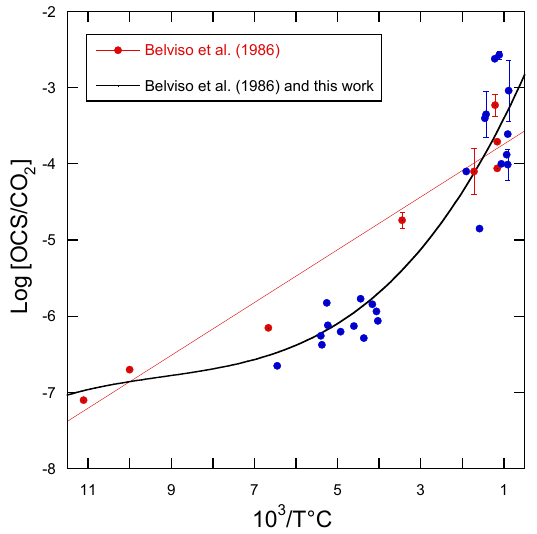
Figure 10. Decimal logarithm of the OCS/CO 2 ratios plotted against the reciprocal of the emission temperature of the gases for volcanoes. The red dots refer to the analytical data published by Belviso et al. (1986) and the red line corresponds to the linear model used in that study to evaluate the volcanic contribution to the atmospheric OCS budget. The blue dots refer to measurements published by others since 1986 (Chiodini et al., 1991; Notsu and Toshiya, 2010; Sawyer et al., 2008; Symonds et al., 1992). The bet- ter fit through all measurements is obtained using a polynomial of the third order ( R 2 = 0 . 89, n =